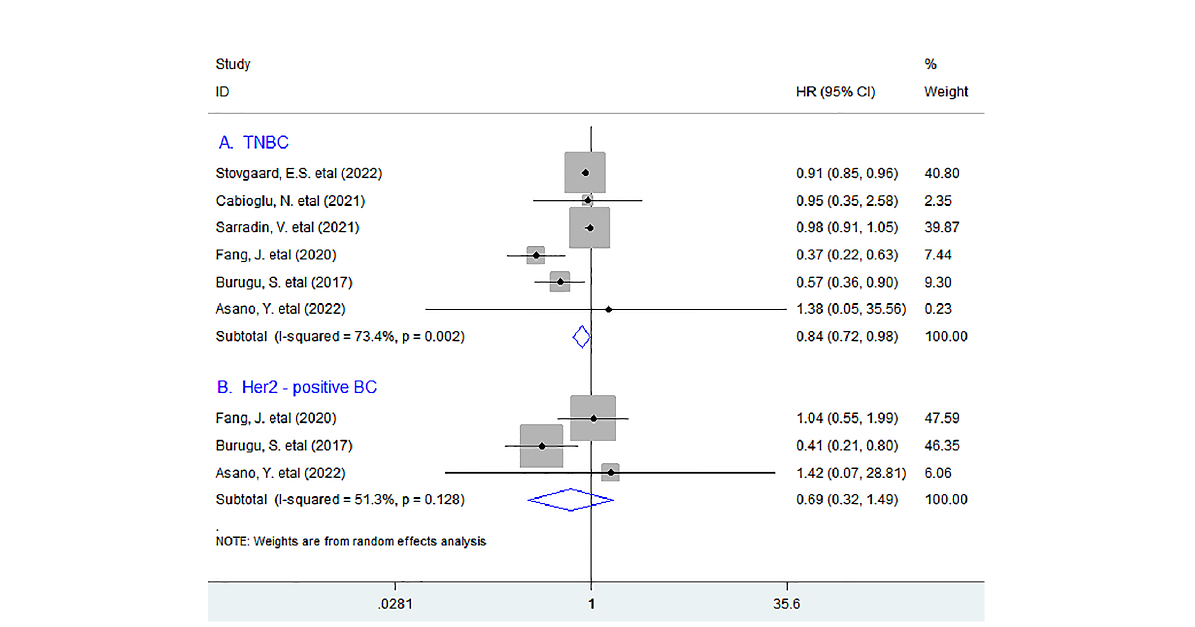
FIGURE 2 Strati fi ed analyses describing HRs of the association between LAG-3 + tumor-in fi ltrating lymphocytes and OS in TNBC and Her2-positive breast cancer. TNBC, triple-negative breast